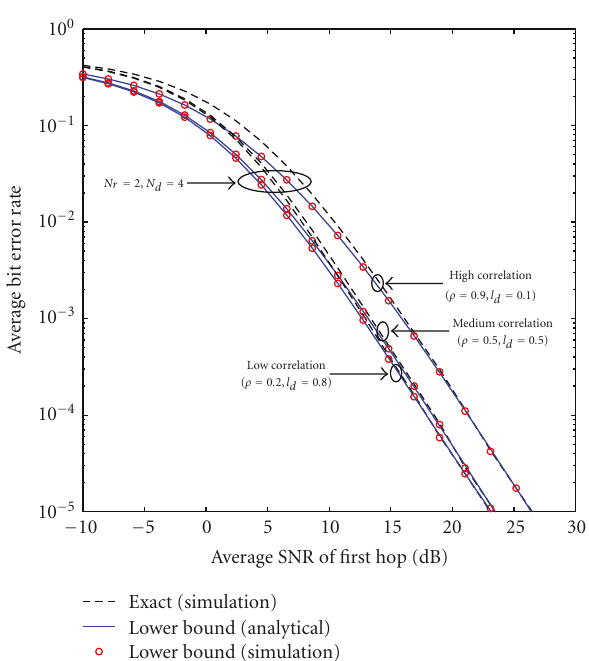
Figure 9: Impact of destination antenna angular spread on the outage probability of dual-hop MIMO relaying with uncor- related antennas at the relay and correlated antennas at the = γ = / 2, θ d = π/ 6, and σ 2 d 1 2 destination. γ 1 π/